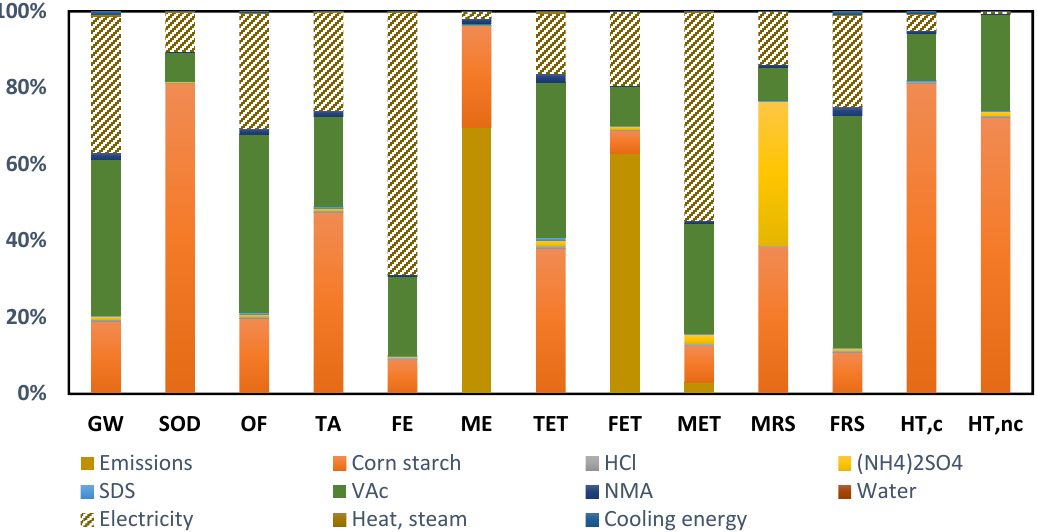
Figure 3. Environmental profile of the hydrolyzed starch bioadhesive with N-methyl acrylamide (Alternative 2).